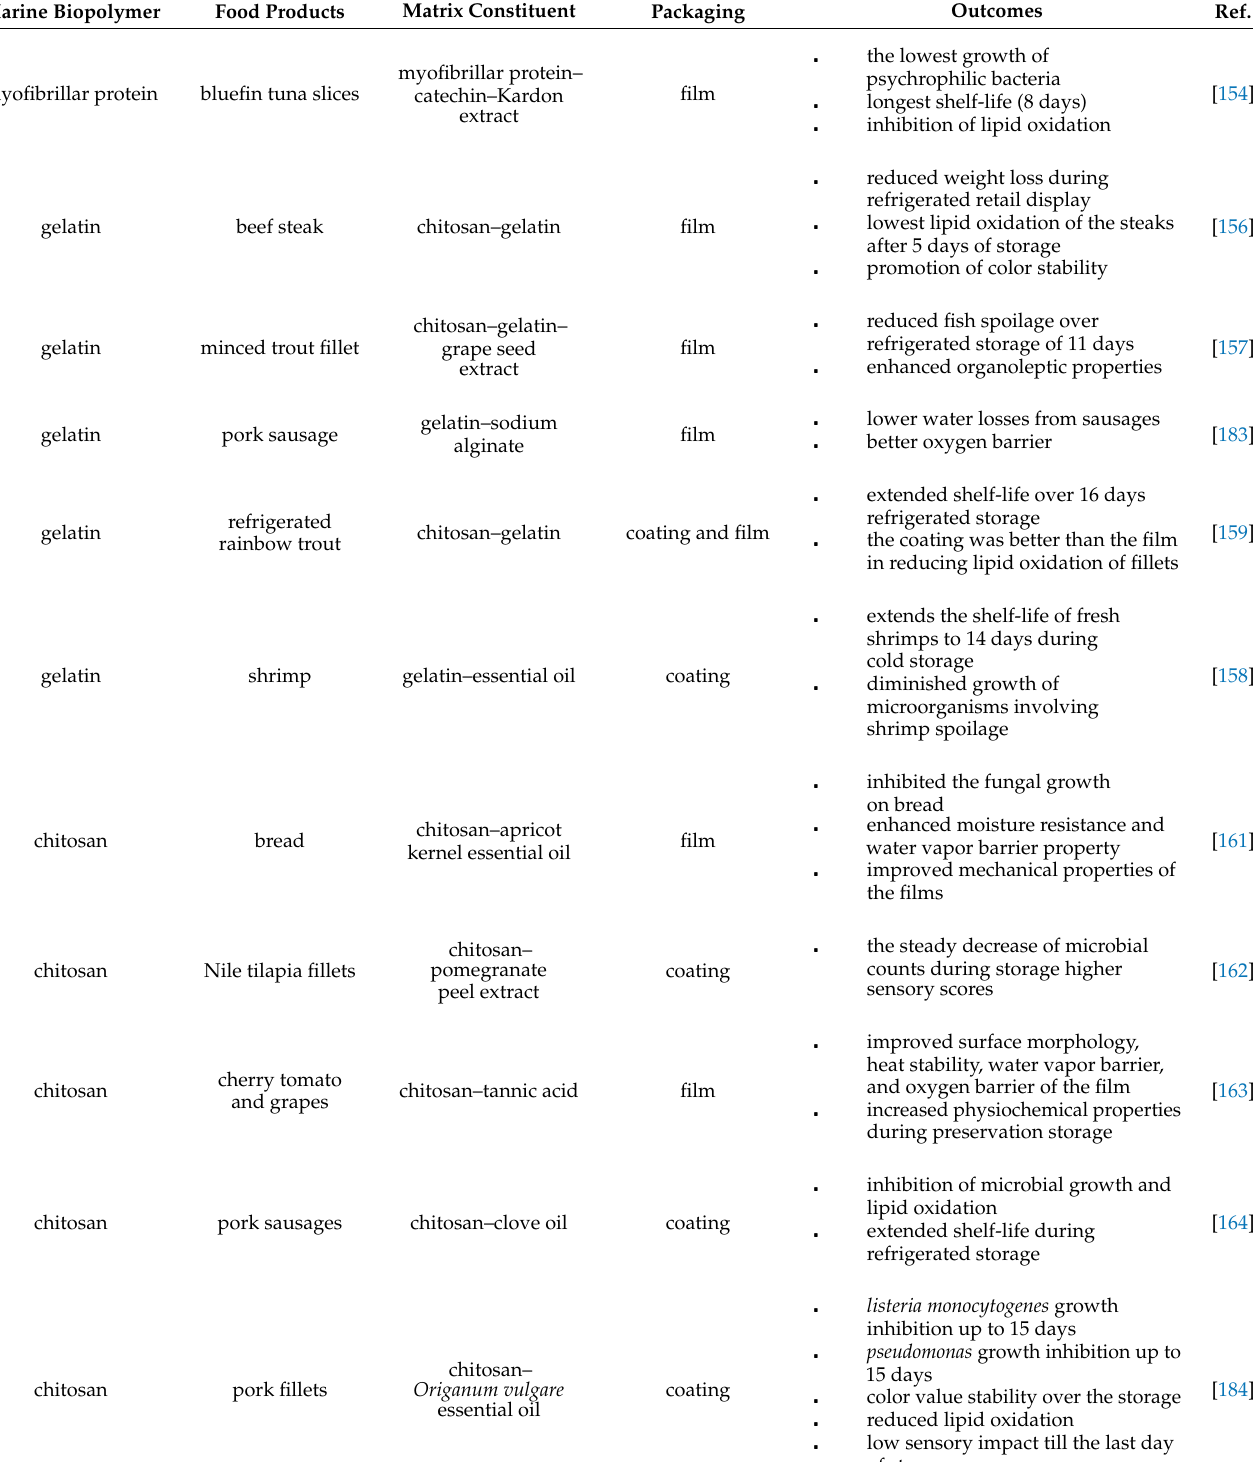
Table 1. Application of protein and polysaccharide biopolymers derived from marine resources in combination with active agents in food